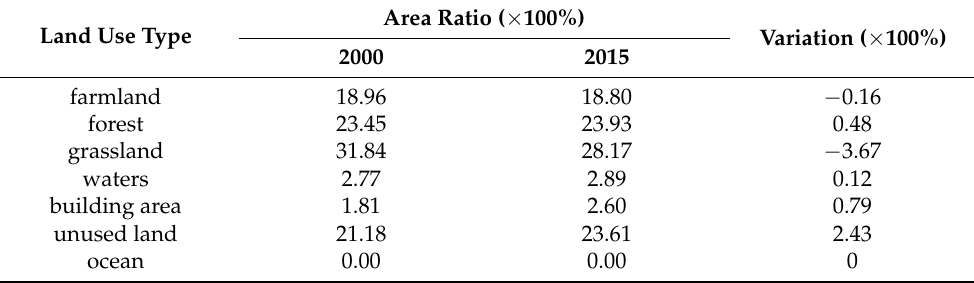
Table 1. Land use in 2000 and 2015.